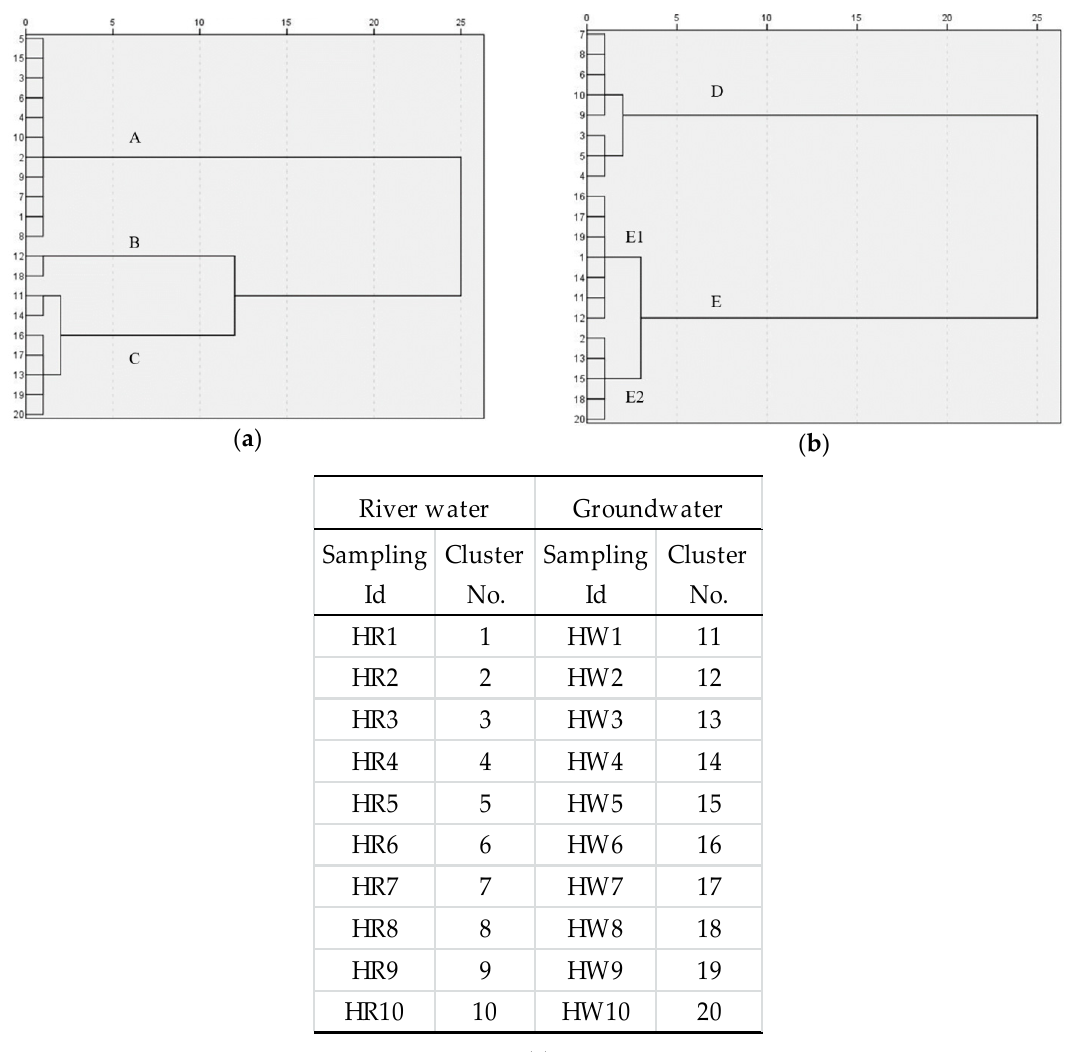
Figure 5. Dendrogram based on hierarchical clustering (Ward’s method) in ( a ) wet season and ( b ) dry season. ( c ) Relation of Hanumante river water (HR) and Hanumante groundwater (HW) with cluster number in dendrogram.